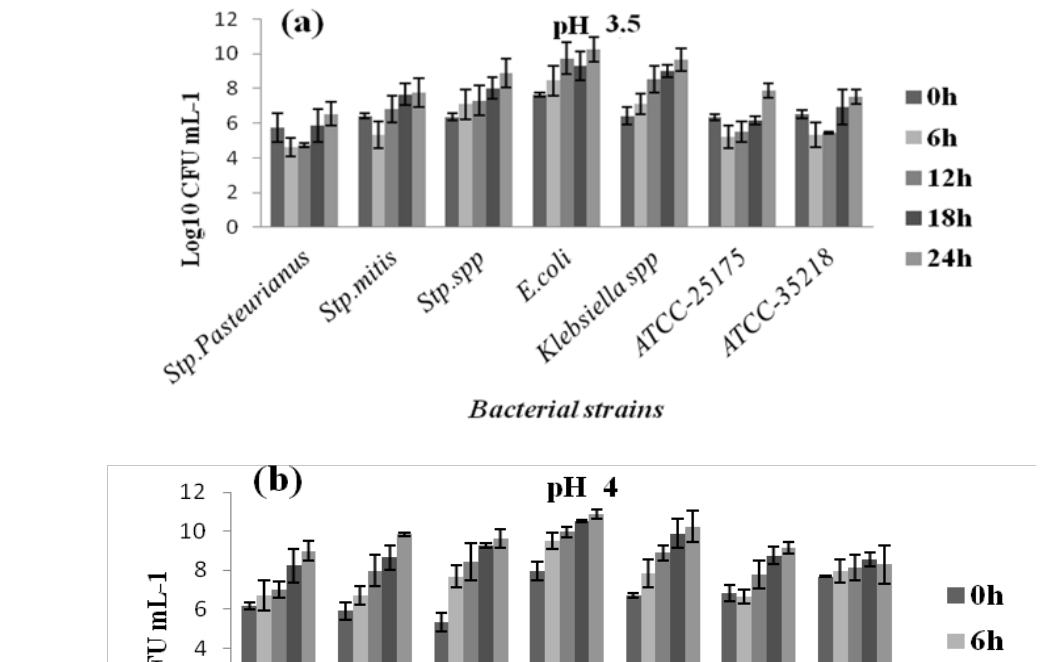
Figure 6. Growth of vaginal staphylococcus strains at pH 3.5 ( a ); pH 4 ( b ); and pH 4.5 ( c ).